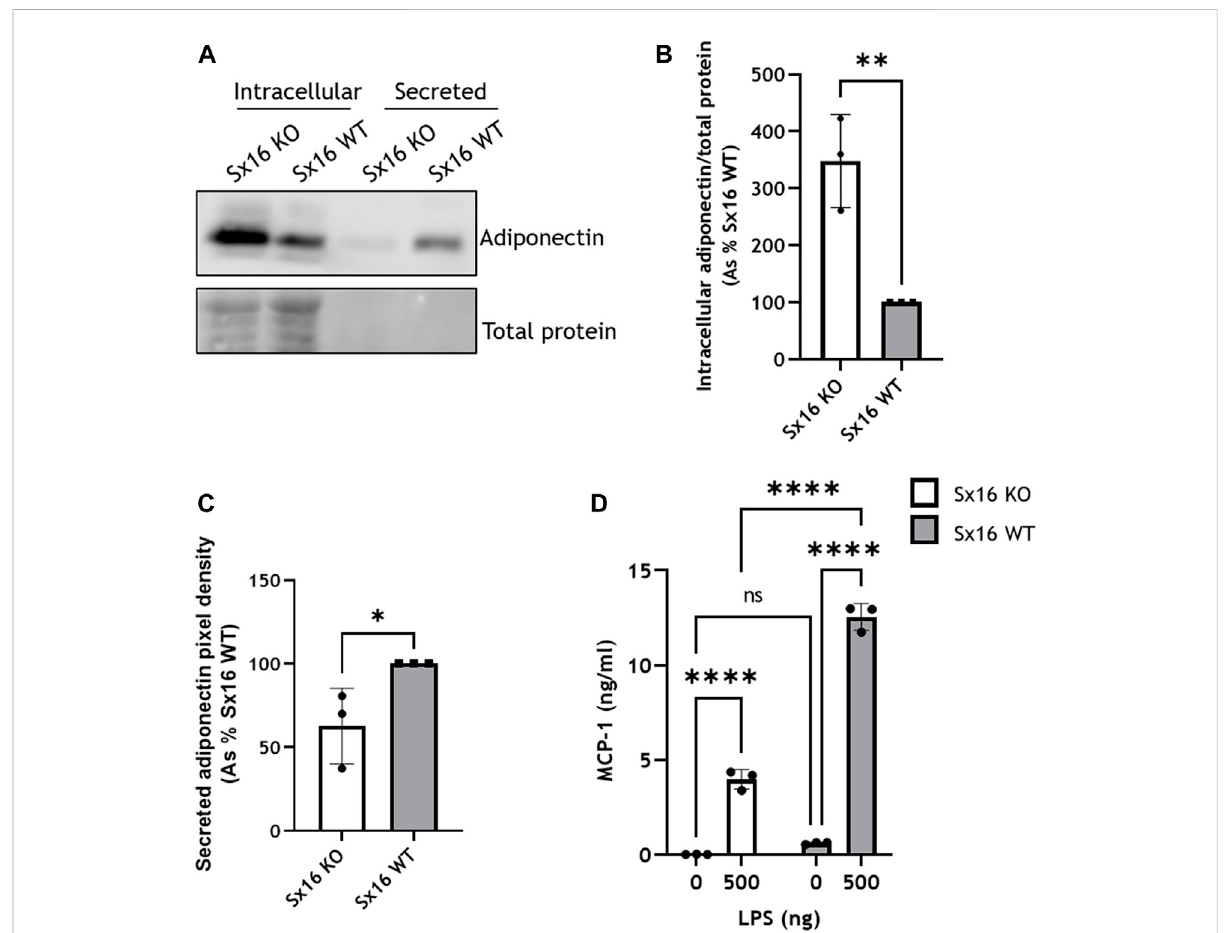
FIGURE 7 Adipokine secretion in impaired in Sx16 knockout adipocytes. (A) Adipocytes were cultured in serum free DMEM for 18 h prior to media collection and preparation of cell lysates from Sx16-KO or WT cells as described. Shown is a representative immunoblot of adiponectin and total protein stain (B) Quanti fi cation of intracellular adiponectin relative to total protein stain by densitometric analysis (C) Quanti fi cation of secreted adiponectin by densitometric analysis (D) Adipocytes were stimulated with 500 ng lipopolysaccharide (LPS) for 18 h in serum free media, conditioned media was collected and MCP-1 content assessed by Quantikine ® ELISA. Data shown represent the mean ± SD of three independent experiments. * p < 0.05, ** p < 0.01, *** p < 0.001 and **** p < 0.0001; n.s. = non signi fi